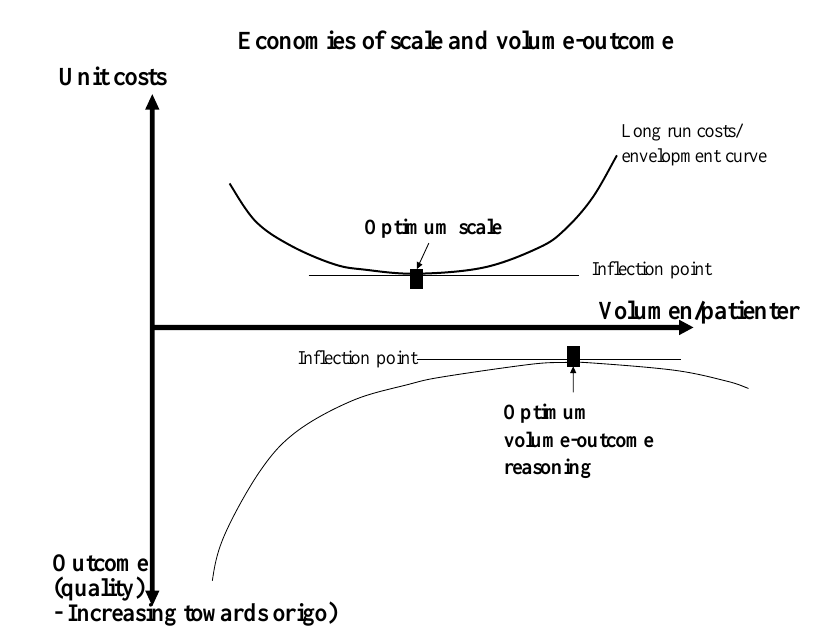
Figure 1: Economies of scale and outcome-volume (Pedersen, 2005) Economies of scale and volume-outcome Unit